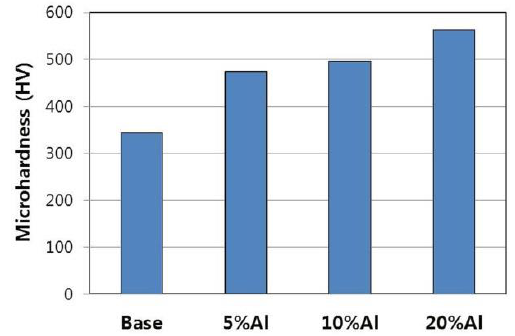
Figure 3. Micro-hardness of as-cast Cr–xAl–5%Si alloys.